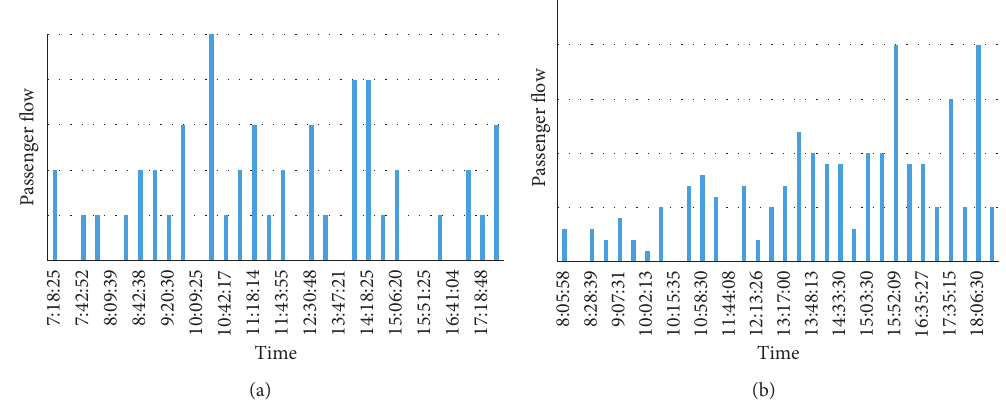
Figure 4: An example of the passenger flow of same stop under different timetables.